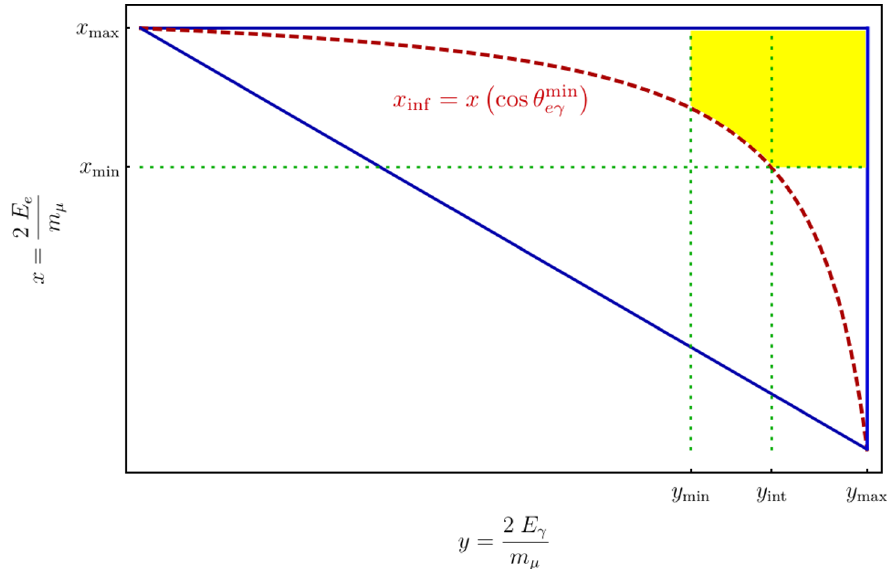
Figure 7 . Illustration of the allowed phase space region for the process µ → e γ φ in a given experiment. The blue continuous lines correspond to cos θ eγ = ± 1 and therefore delimit the total phase space that would be in principle available due to kinematics. The red dashed line represents x inf ( y ) and corresponds to the minimal θ eγ angle measurable by the experiment, excluding the region below it. The green dotted straight lines at x min and y min are the minimal positron and photon energy, respectively, that the experiment can measure, while y int is the value of y for which x min and x inf intersect. Finally, the yellow surface is the region where we must